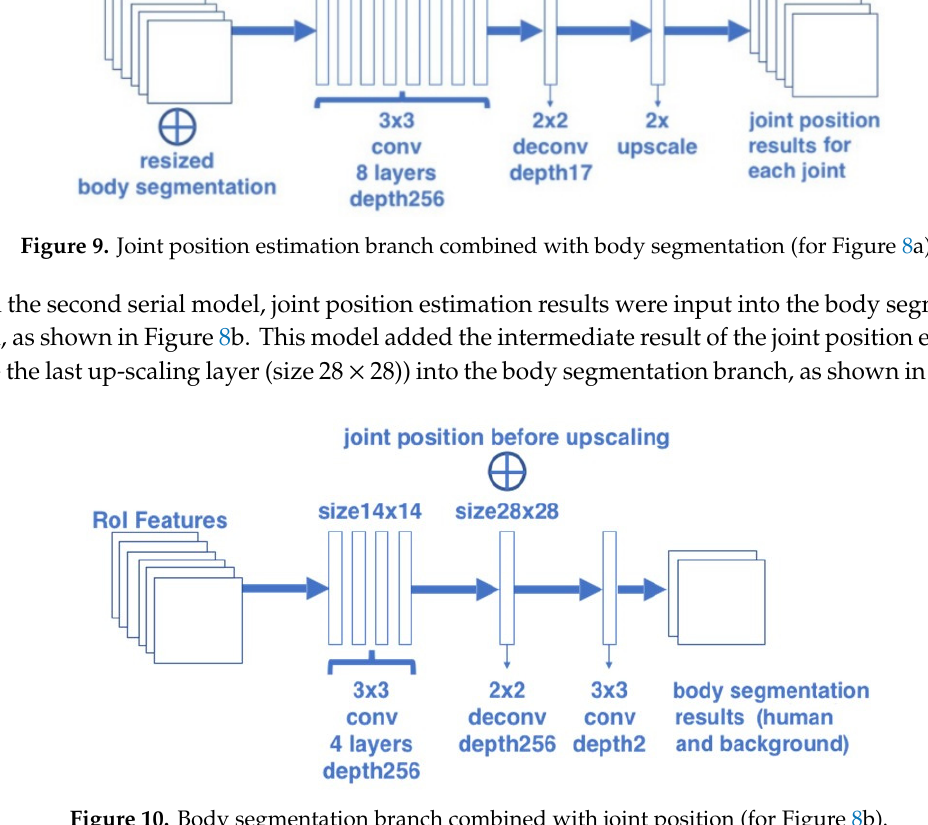
Figure 10. Body segmentation branch combined with joint position (for Figure 8b).